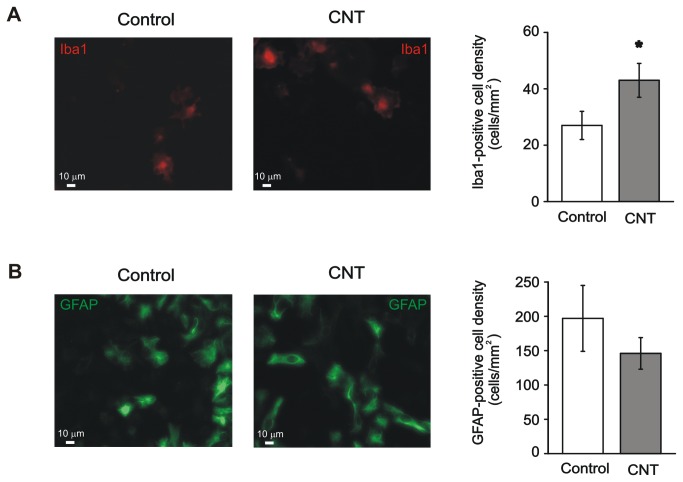
MWCNTs impact on the density of non-neuronal cells in spinal cord cultures.(A) Left, images of control and CNT spinal cultures immunostained for the microglia/macrophage marker Iba1. Right, the density of Iba1-positive cells is increased in CNT cultures (*: P<0.05). (B) Left, images of control and CNT spinal cultures immunostained for the glial marker GFAP. Right, the density of GFAP-positive cells is similar in control and CNT cultures.